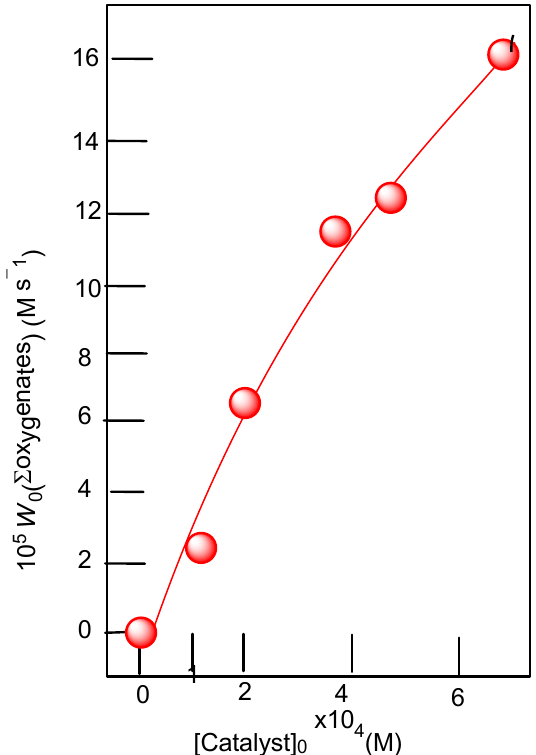
Figure 10. Dependence of the initial rate of oxygenate (sum cyclohexanol+cyclohexa- none) formation W 0 for complex 4 on the initial concentration of catalyst. (Initial concen- H 2 O 2 1.5 M, catalyst 5 × 10 − 4 M, HNO 3 0.05 M, CH 3 CN up to 2.5 mL, T = 50 ◦ trations: cyclohexane 0.46 M, H 2 O 2 1.5M, catalyst 5×10 − 4 M, HNO 3 0.05M, CH 3 CN up to 2.5 ml, T = 50 °C).